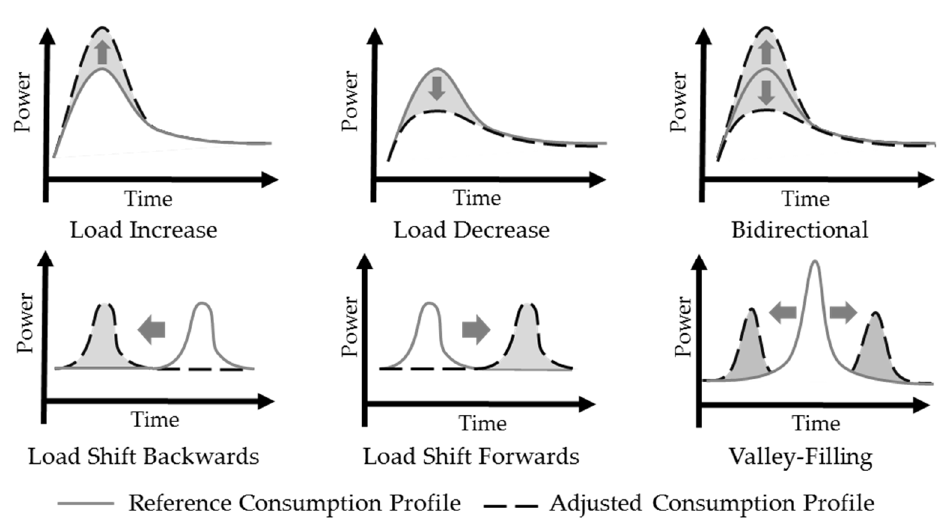
Figure 7. Di ff erent flexibility types of EFMs (Adapted from References [39,40], own Figure 7. Different flexibility types of EFMs (Adapted from References [39,40], own illustration).